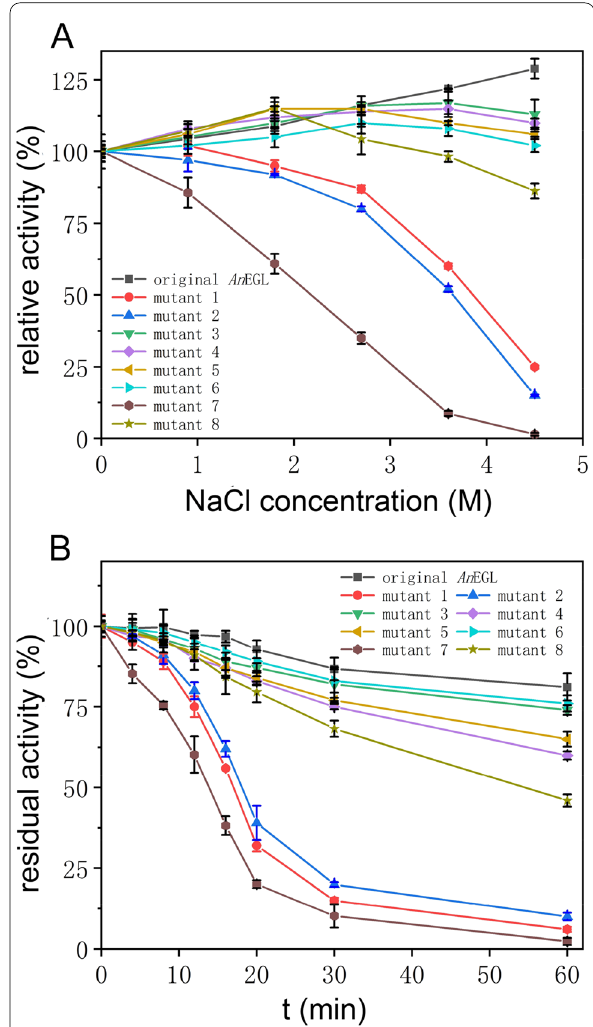
Fig. 6 The salt tolerance and thermostability of An EGL and its mutants. A Influence of NaCl concentration on activity at 50 °C pH 4.0. B The thermostability at 65 °C pH 4.0 with the presence of 4.5 M NaCl. The mutation sites of mutant 1–8: mutant 1 (D95N), mutant 2 (D99N), mutant 3 (E55Q), mutant 4 (D114N), mutant 5 (E157Q), mutant 6 (K159T), mutant 7 (D95N, D99N), mutant 8 (E55Q, D114N, E157Q,